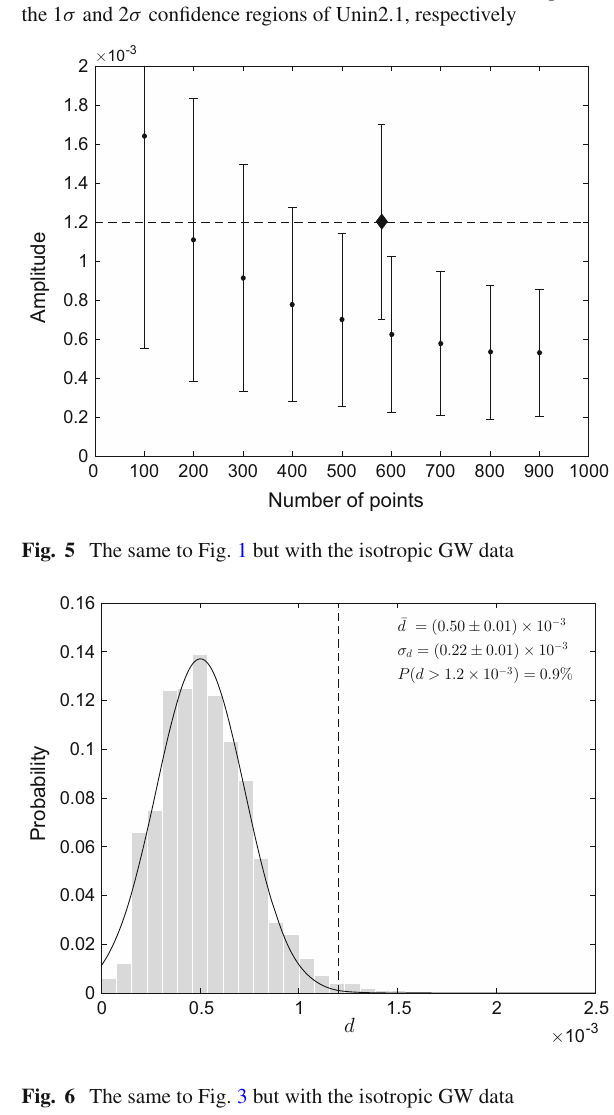
Fig. 6 The same to Fig. 3 but with the isotropic GW